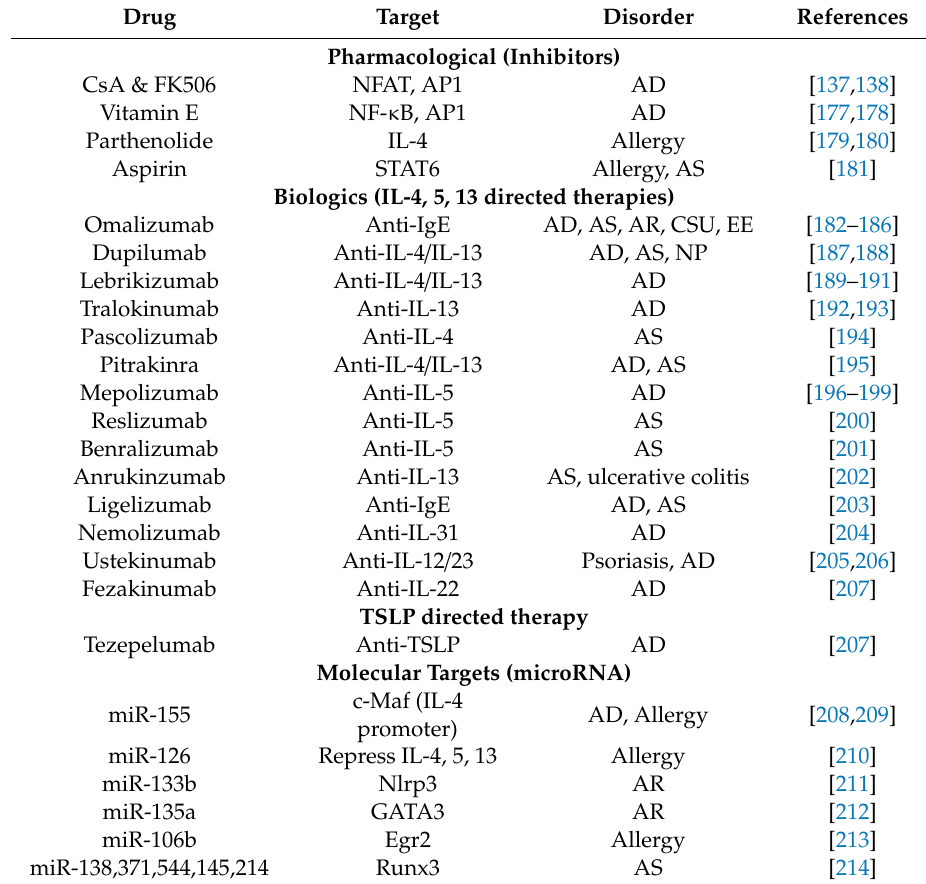
Table 2. Approaches for treatment of Th2-mediated immune